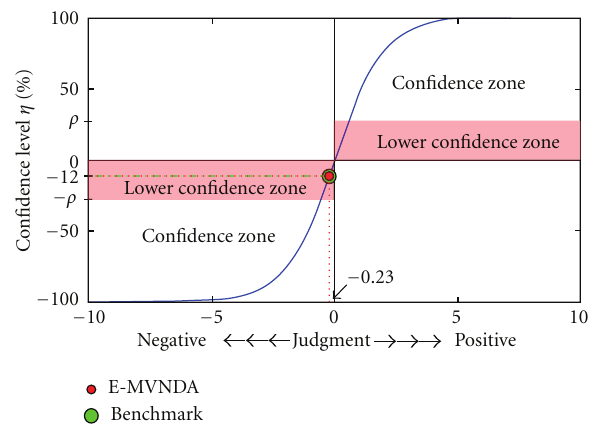
Figure 7: Group decisions by E-MVNDA and benchmark. In this study, both decisions of E-MVNDA and benchmark lie in the lower confidence zone.